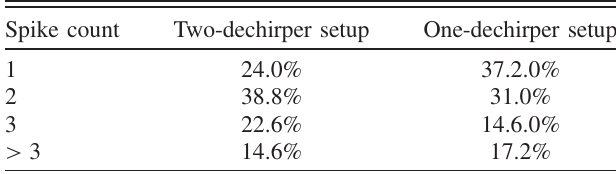
TABLE II. Statistics of XFEL pulses in the frequency domain of two dechirper configurations on 500 shots of simulations. Spike count Two-dechirper setup One-dechirper setup